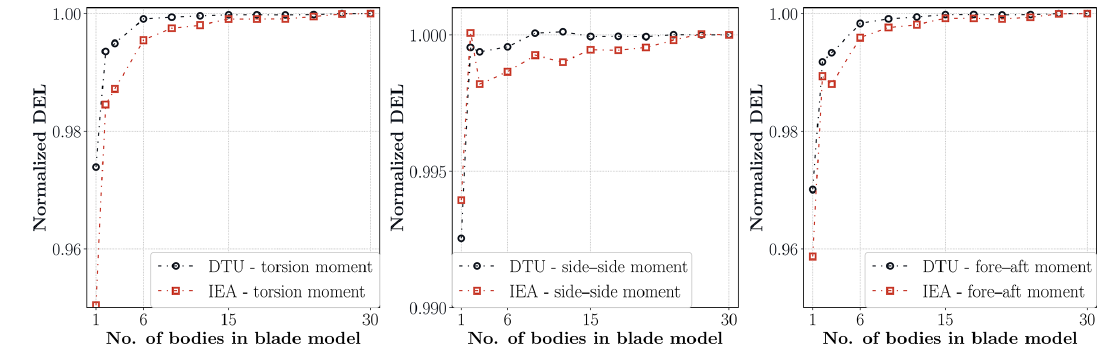
Figure 11. Normalized tower-top torsion, side–side and fore–aft DEL moment with respect to number of sub-bodies in blade model.